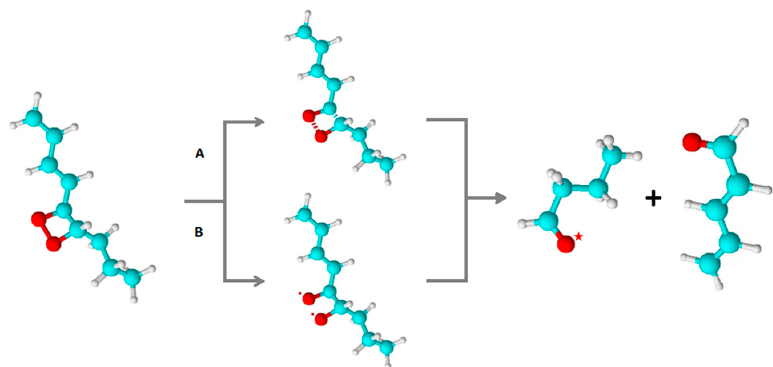
Figure 8. Thermal decomposition of 1,2-dioxetane by concerted ( A ) and diradical ( B ) mechanisms. In ( A ), the concerted mechanism involves the simultaneous cleavage of oxygen-oxygen and carbon-carbon bonds. In ( B ), diradical mechanism contains the cleavage of the oxygen-oxygen bond, resulting in the formation of diradical, followed by the cleavage of the carbon-carbon bond. Both mechanisms result in the formation of triplet exited carbonyl and ground state carbonyl.